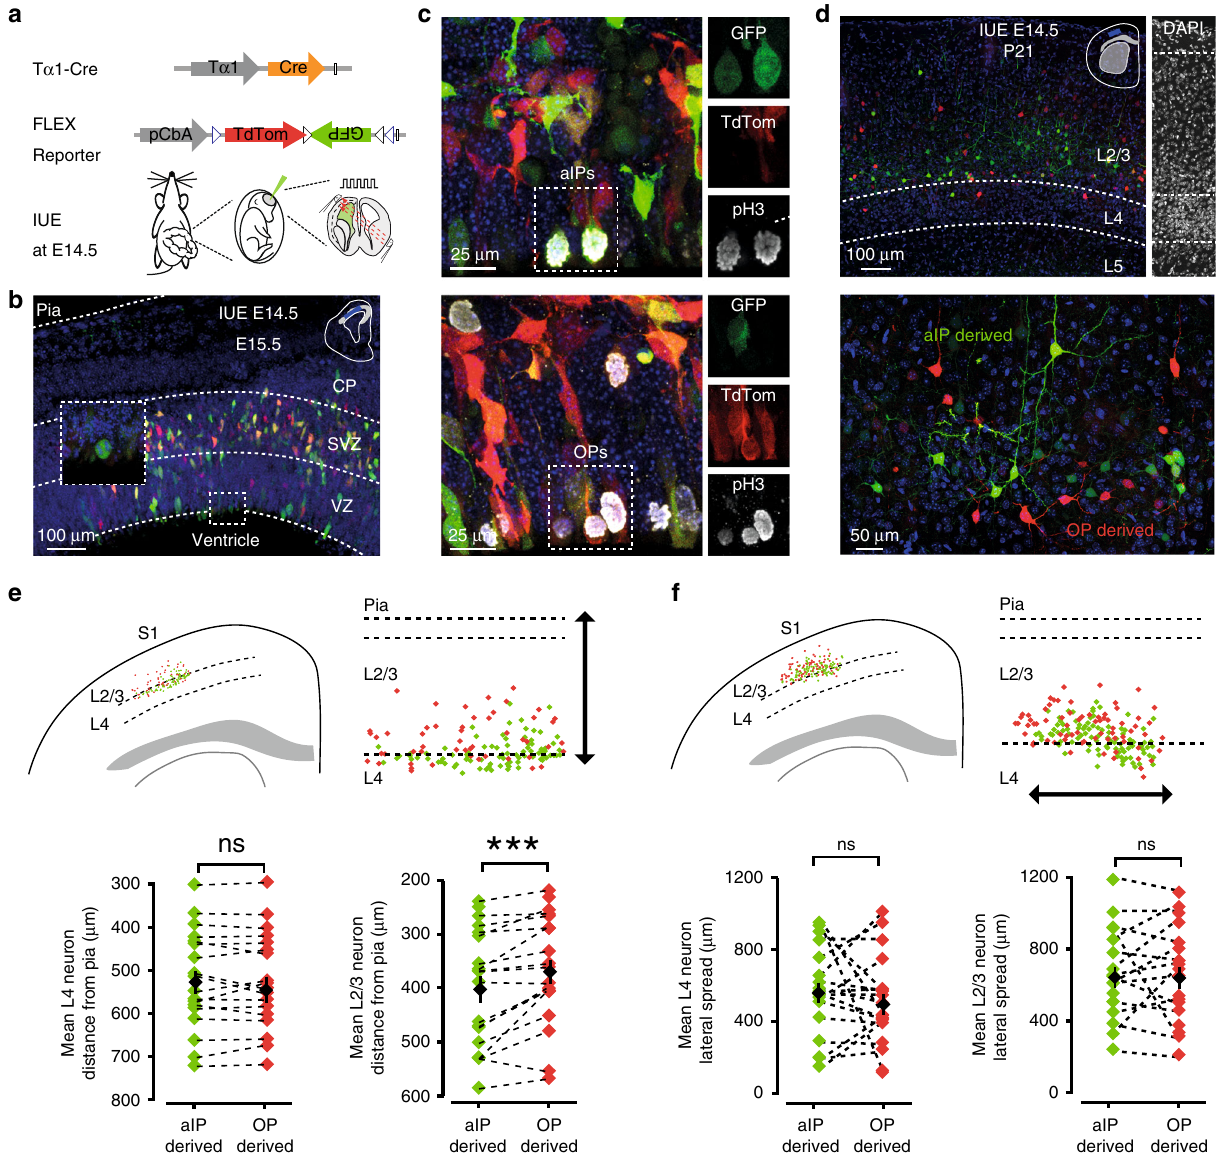
Fig. 1 In utero labeling of neurons derived from different progenitor pools. a In utero electroporation (IUE) was used to deliver a T α 1-Cre and two-color C β A-FLEx reporter plasmid into mouse cortical progenitor cells. b 24 h later, GFP-expressing cells in the VZ exhibited properties of apical intermediate progenitor cells (aIPs), including a lack of basal process during mitosis (inset). Cells expressing only TdTomato exhibited properties associated with other progenitors (OPs). c Actively dividing aIPs (top) and OPs (bottom) were positive for the mitotic marker phospho-histone H3. d One month after IUE (P21), L4 and L2/3 neurons within somatosensory cortex (top) could be distinguished as either aIP-derived (GFP + ) or OP-derived (TdTomato + ; bottom). Cortical layers were delineated with DAPI staining. e Representative postnatal brain slice and corresponding scatter plot (top) indicating the positions of aIP- derived (green) and OP-derived (red) neurons. Within L4, the mean radial position of the two neuronal populations was similar (bottom; p = 0.97, paired t - test, n = 19). Within L2/3, the mean radial position was deeper for aIP-derived neurons compared with the OP-derived population ( p = 0.0005, paired t - test, n = 19). f Example brain slice and scatter plot indicating the lateral spread of labeled neurons (top). The lateral extent of aIP- and OP-derived neurons was not different within L4 or L2/3 (bottom; p = 0.45 and p = 0.97, respectively, paired t -test). Error bars represent standard error of the mean.